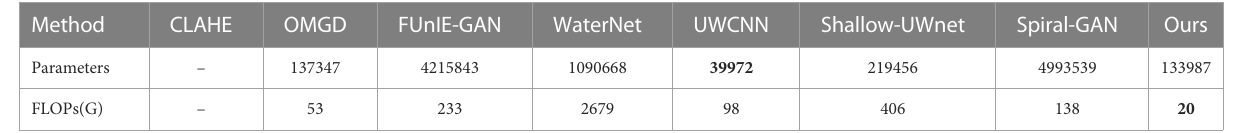
TABLE 5 Parameters and FLOPs of different methods on the 1280×960 underwater video.